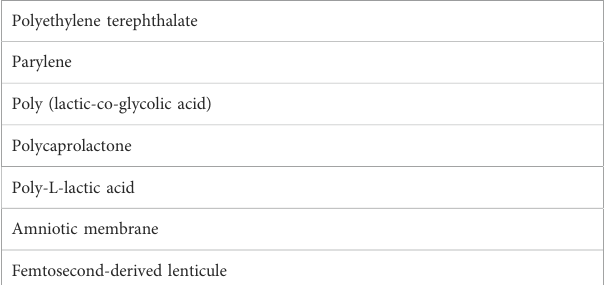
TABLE1Materialsusedasscaffoldsforthetransplantationofstemcell-derived retinal pigment epithelial cell monolayers. Polyethylene